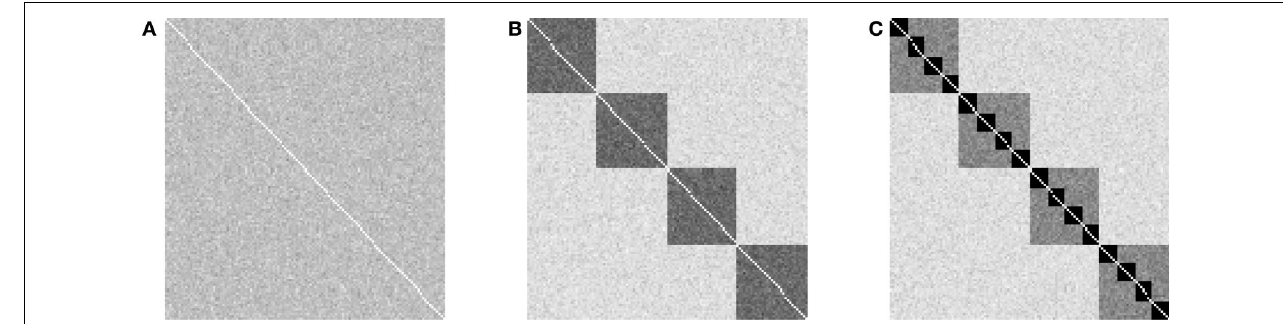
FIGURE 1 | Overview of variation of granularity and scales in the explored hierarchical modular networks. The plots show the outcome of 100 realizations of networks with 128 nodes and 4,096 directed edges. Gray level shading of the adjacency matrix indicates the frequency with which an edge was established (white: never established; black: established in all 100 generated networks). (A) Random networks without hierarchical structure,